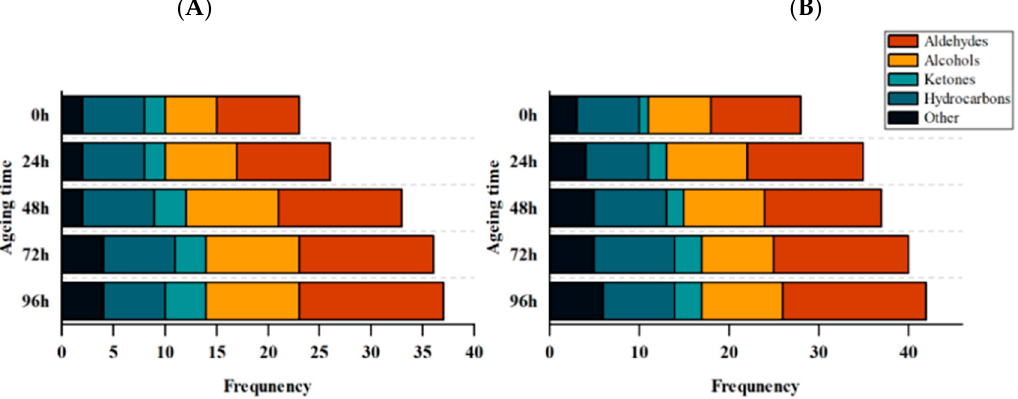
Figure 3. Changes in the species of volatile flavor substances derived from lipid oxidation in LT muscle of the PF and CF during postmortem aging. ( A ) PF and ( B ) CF. The capital letters indicate significant differences in feeding regimes ( p < 0.05), and the lowercase letters represent significant differences at different time points during postmortem aging ( p < 0.05).